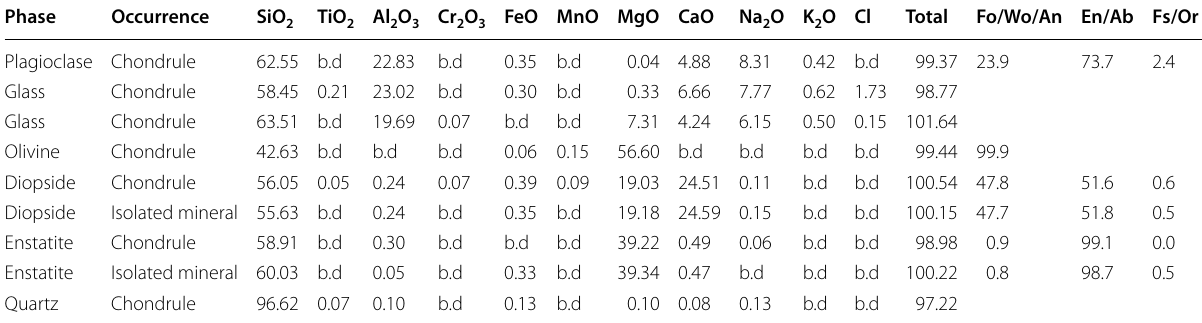
b.d.: below detection limits (3σ), 0.03 for SiO 2 , Al 2 O 3 , MgO, and CaO, 0.04 for TiO 2 , Na 2 O, and K 2 O, 0.05 for FeO, Cr 2 O 3 , and Cl, and 0.08 for MnO Table 3 Representative analyses of opaque minerals (wt%)